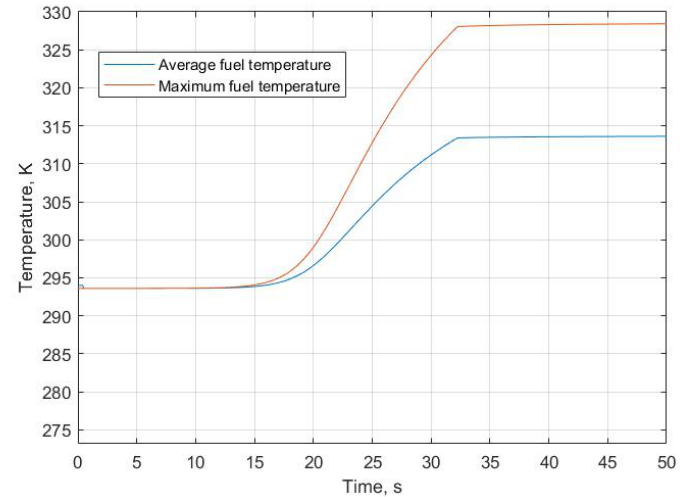
Figure 12. Maximum and average time-dependent fuel temperatures calculated by Griffin during the SIRIUS-CAL